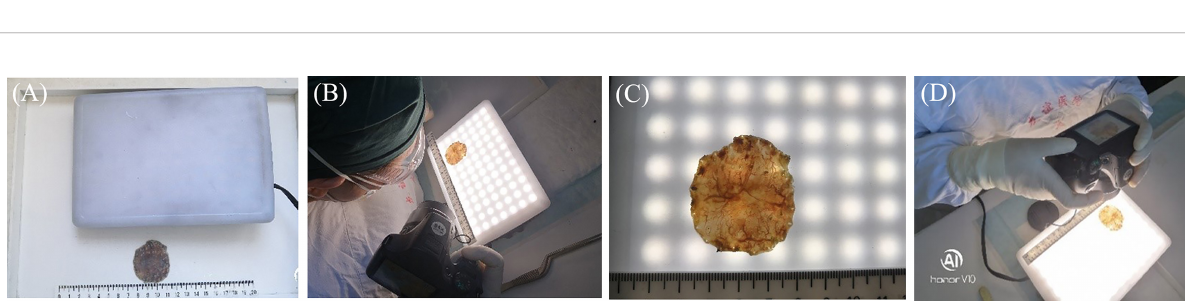
FIGURE 2 | Endoscopic images of early gastric cancer. (A) White light imaging observations: A 25-mm fl at elevated lesion is observed on the anterior wall of the gastric angle, and the center is slightly depressed (black dotted lines). (B) Narrow-band imaging observations: An enlarged mucosal pattern and irregular depression surface are observed (black dotted lines). (C) The endoscopic submucosal dissection resected specimen is fi xed with a fi ne needle on a foam plate.